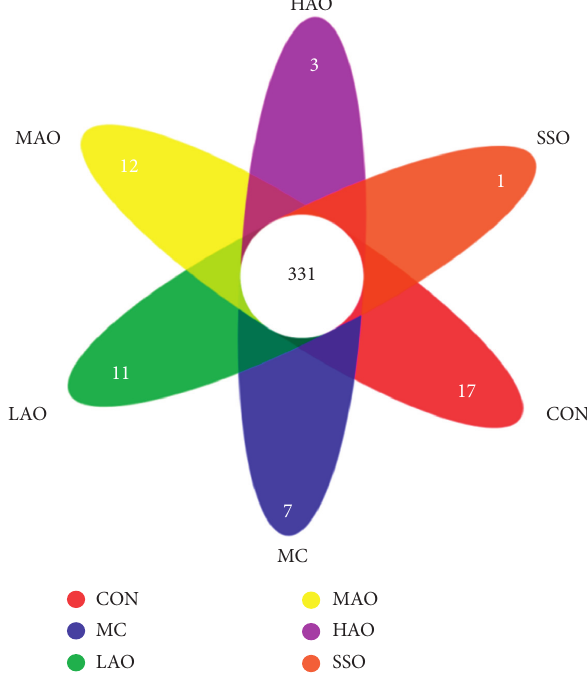
Figure 8: Venn diagrams of the OTUs between different